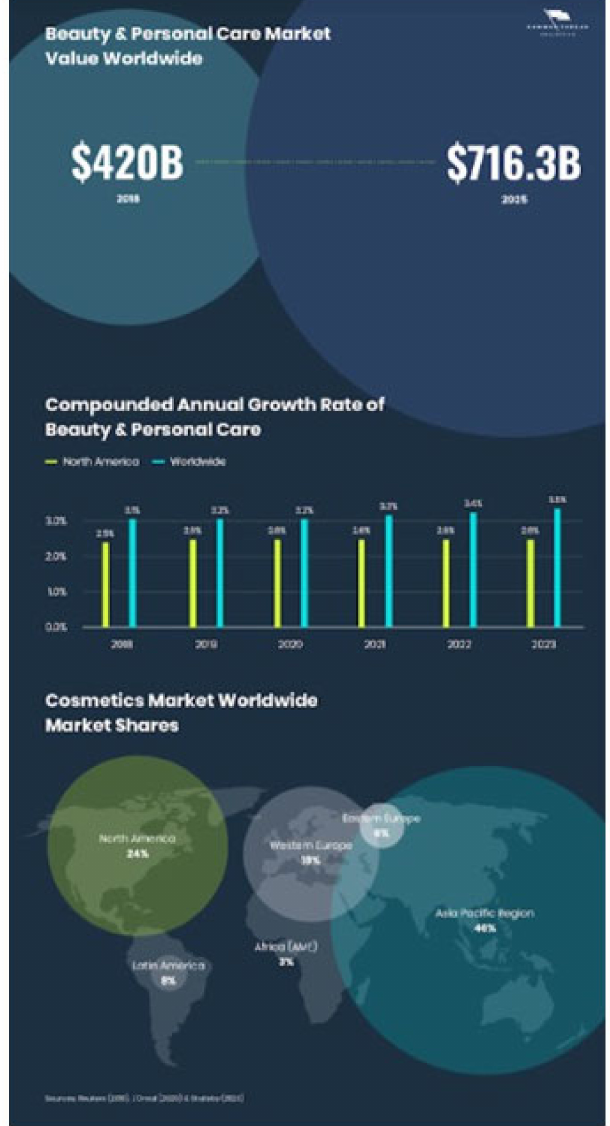
Figure 15. The worldwide previsional Beauty and personal carecosmetic markets 2019–2025 (by the courtesy of Common Thread